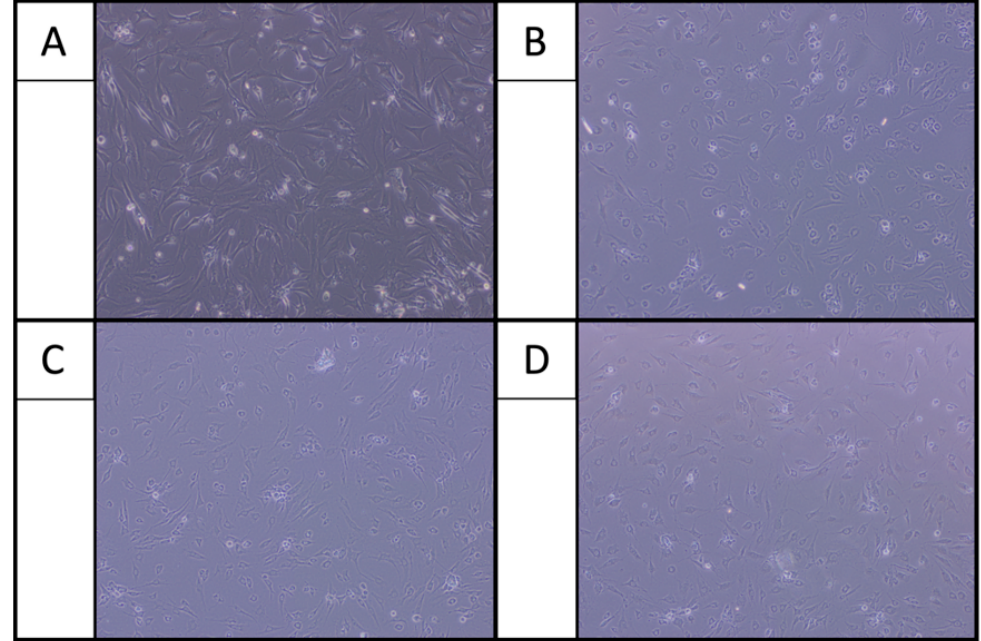
Figure 1. Reduced cell adherence after treatment with LA ( B ) bupivacaine, ( C ) lidocaine and ( D ) ropivacaine compared to the control group in the culture medium ( A ).